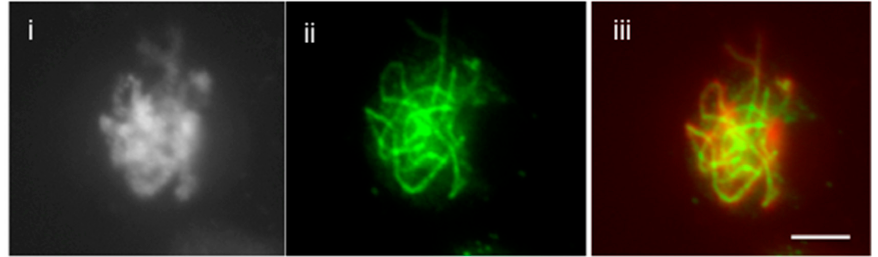
Figure 2. Immunolocalization of SYN1 in paraformaldehyde-fixed male meiocytes without enzymes. (i) DAPI-stained pachytene chromosome, (ii) SYN1 stained pachytene chromosome and (iii) Merged. Chromosomes are counterstained with DAPI (left image of each panel); Bar = 10 μ m.